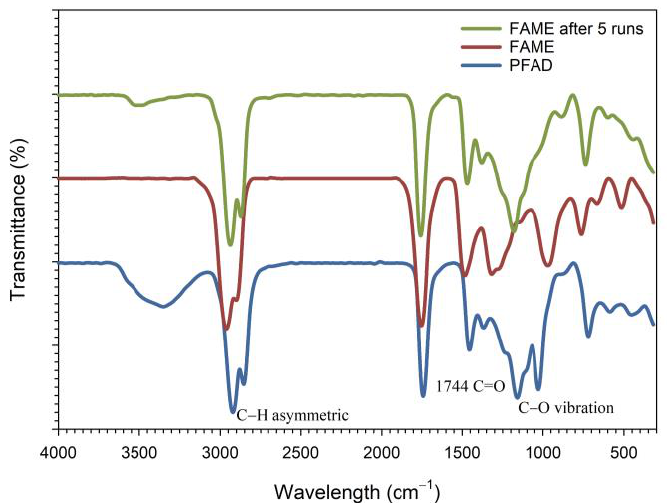
Figure 8. Ex situ FT-IR spectra of PFAD biodiesel produced by esterification reaction using the Cu 2 S (8%) -FeS (10%) /SiO 2 catalyst after five runs at the reaction conditions of 70 °C, 2 wt.% catalyst loading, 15:1 methanol to PFAD molar ratio, and 3 h reaction time.